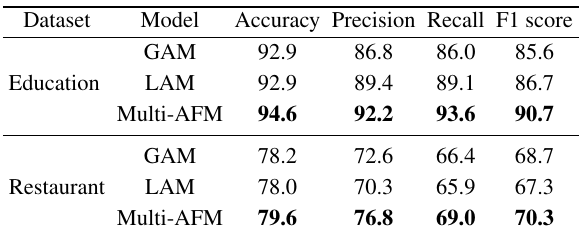
Performance comparison of each model on different